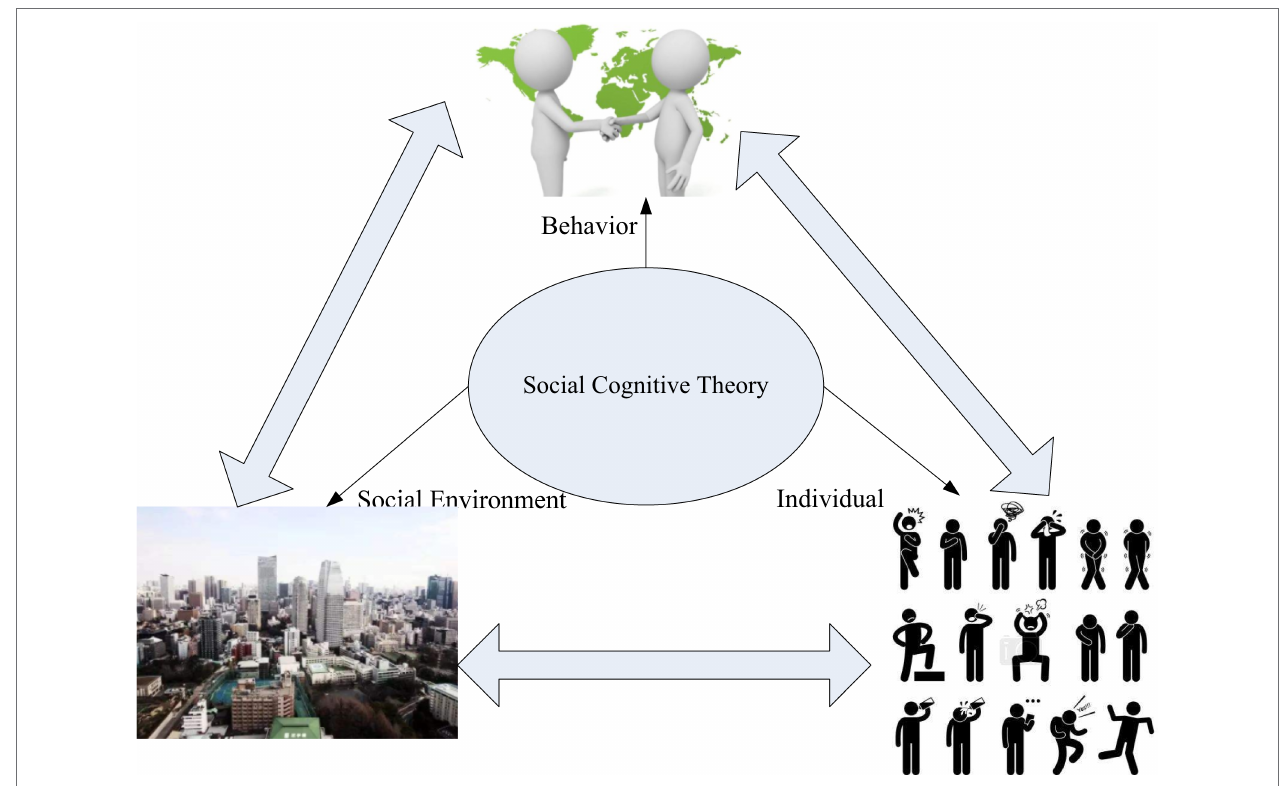
FIGURE 1 | Structure diagram of social cognition